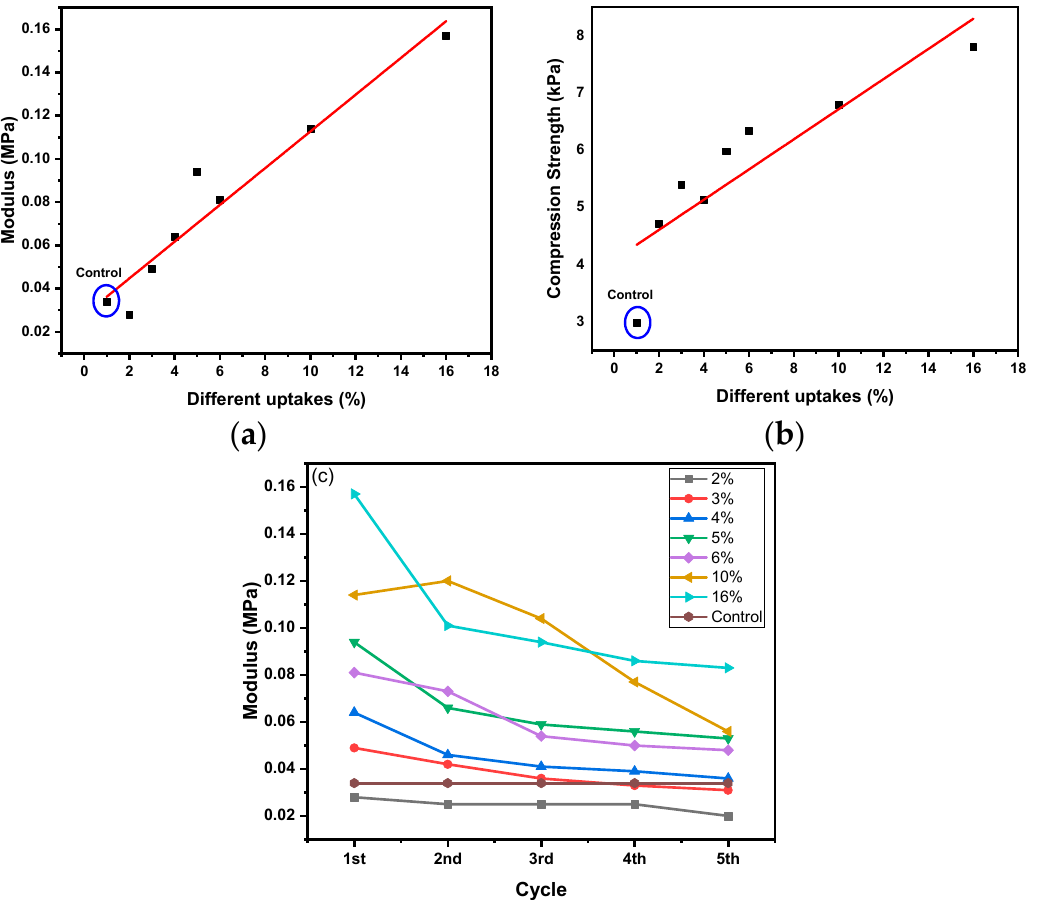
Figure 19. Result of compression test for uncoated and coated PUF in different uptakes. ( a ) Modulus results, ( b ) Compression strength, and ( c ) repeated modulus test.